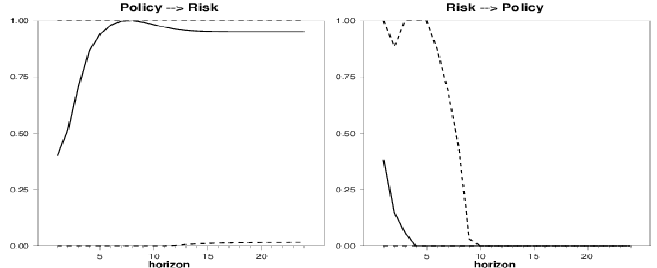
Figure 6. Dashed lines represent the 90% confidence intervals; the values of our measures are between 0 (not significant) and 1. z = GRAI .